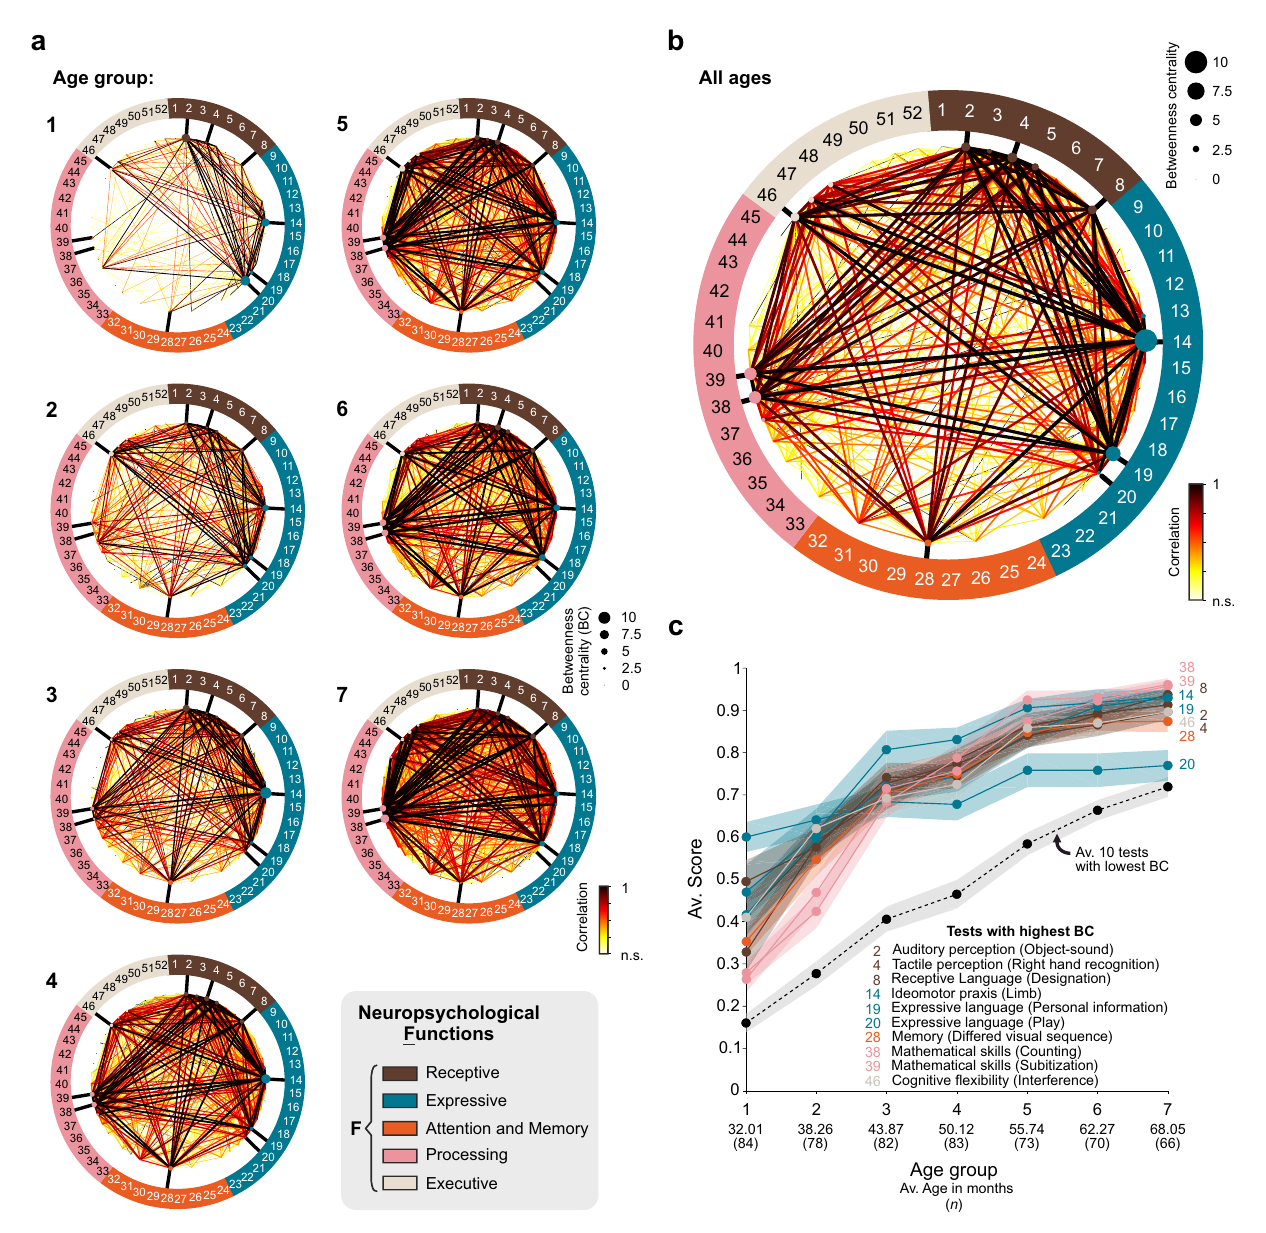
Figure 4. Consolidation/integration of critical neuropsychological functions through development. Network visualization of the cross-correlations across the 52 neuropsychological tasks using the scores from children belonging to each age group ( a ) or from all ages ( b ). Tasks appear as nodes radially arranged along a circumference covering the following domains: receptive (walnut brown), expressive (mosaic blue), attention/ memory (orange), processing (flamingo pink), and executive (cloud cream-yellow) functions. The colors of the lines and their thickness represent the cross-correlation between pairs of tasks, whereas the area of each node is proportional to the betweenness centrality (BC) for each task. ( c ) Developmental profile for the ten tasks with the highest BC compared against the average of ten tasks with the lowest BC (dotted